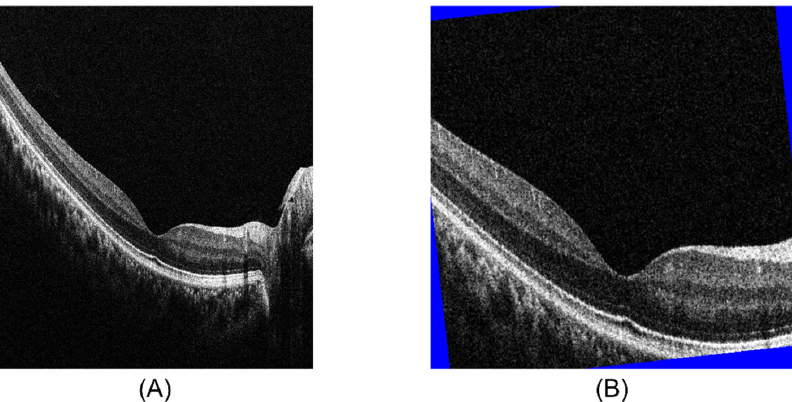
Figure 1. Data augmentation for training the CNN model. Original OCT image ( A ) with a resolution of 1021 × 1176 pixels was center-cropped to 600 × 600 pixels (probability = 50%) and then resized to 512 × 512 pixels. After resizing, the following data augmentations were applied to the images: random brightness from 0.8 to 2.0 times, random contrast from 0.8 to 1.5 times, random rotation within 10 degrees, random horizontal and vertical shift within 50 pixels, and random horizontal mirroring (probability = 50%). ( B ) If margins were created by image processing, these were padded with blue (red, green, and blue color information of 0, 0, and 255, respectively) to prevent misrecognition. Abbreviations: CNN, convolutional neural network; OCT, optical coherence tomography.